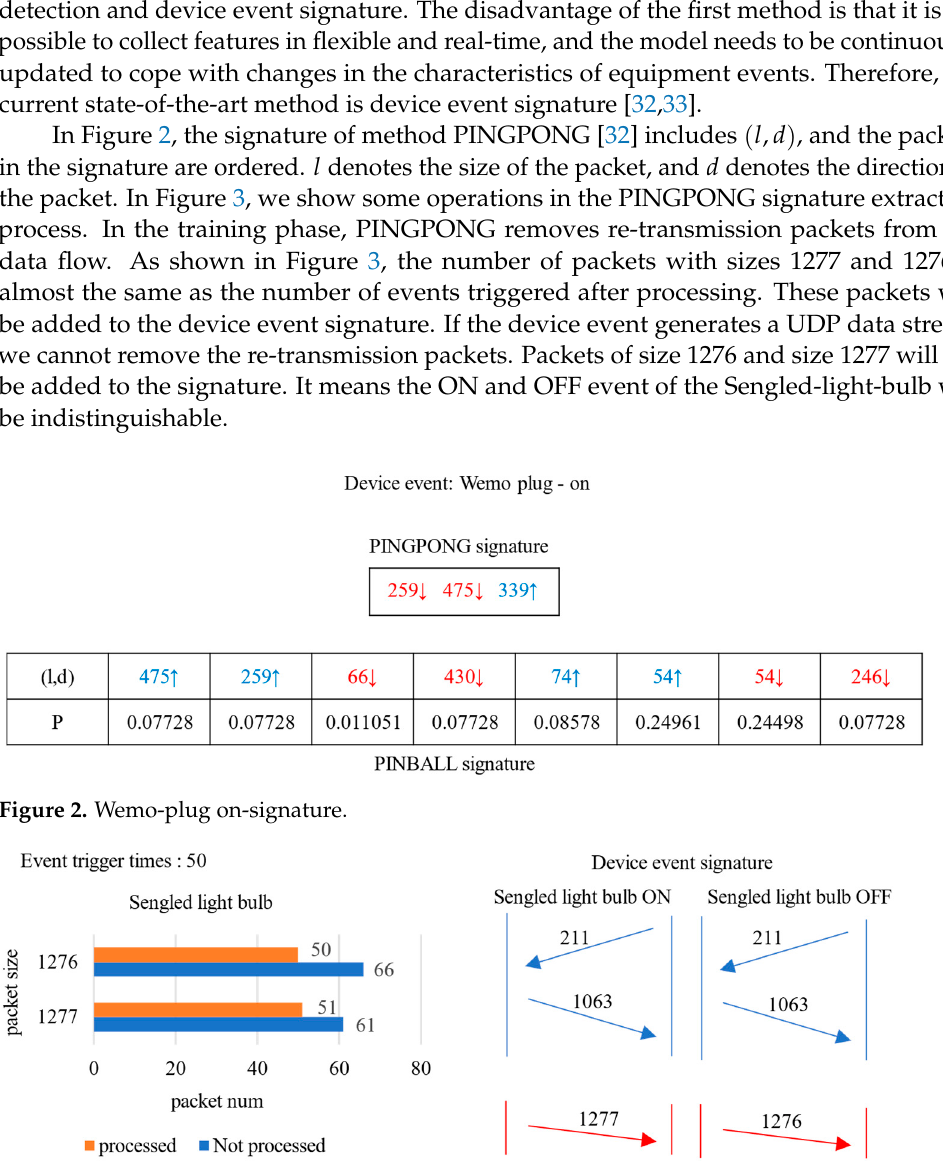
Figure 3. Signature detection process in PINGPONG.